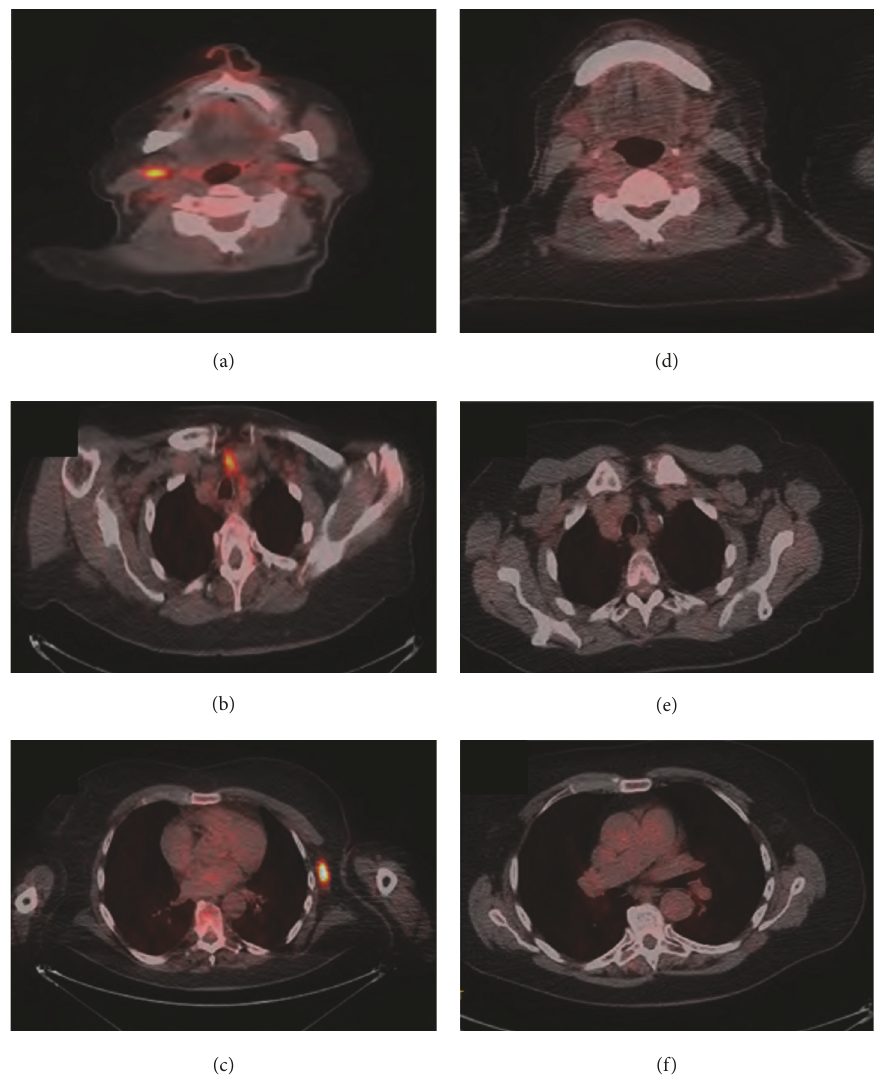
Figure 1: (a, b, c) Diagnostic axial FDG-PET images illustrate FDG-avid axillary, mediastinal, and cervical nodes, respectively. (c, d, f) Posttreatment axial PDG-PET images illustrate no FDG-avid evidence of residual disease at cervical, mediastinal, and axillary nodes,